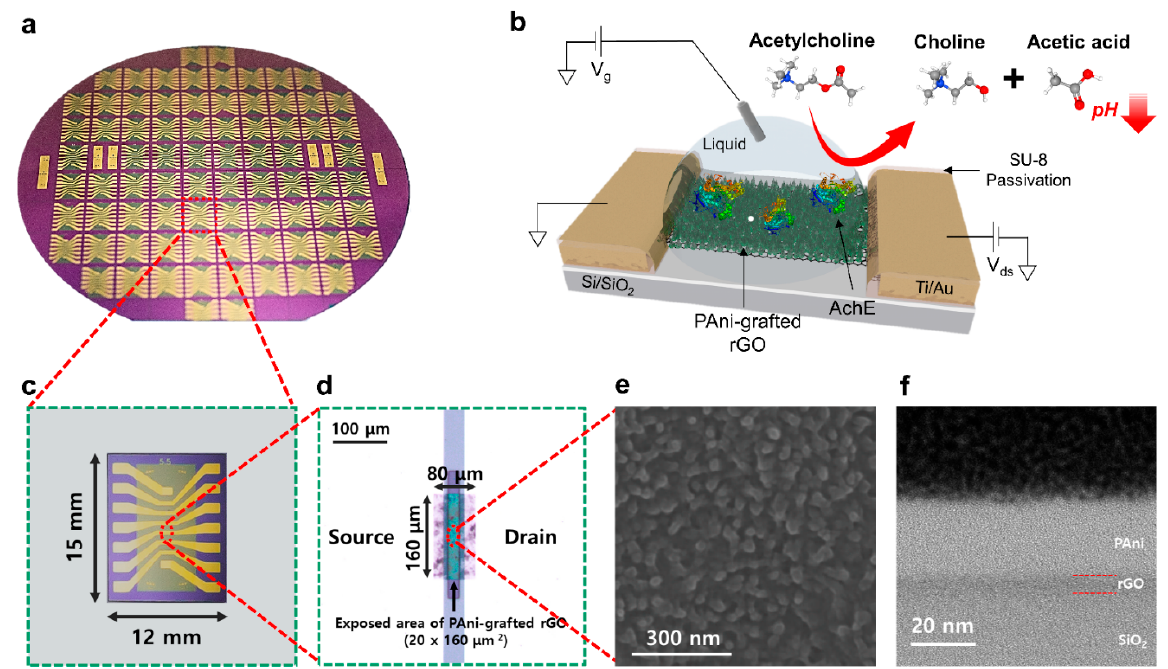
Figure 1. Wafer-scale fabrication of PGFETs for biosensing applications. ( a ) Photograph image of the fabricated PGFETs on a 6-inch wafer. ( b ) Schematic illustration of a PGFET biosensor for monitoring the enzymatic reaction of AchE. ( c ) Photographic image of a single PGFET device. ( d ) Magnified optical microscopy image showing the partially exposed area of PAni-grafted rGO. ( e ) SEM image showing a part of the PGFET channel with the granular structure of grafted PAni. ( f ) TEM image presenting the cross-sectional profile of fabricated PAni-grafted rGO.